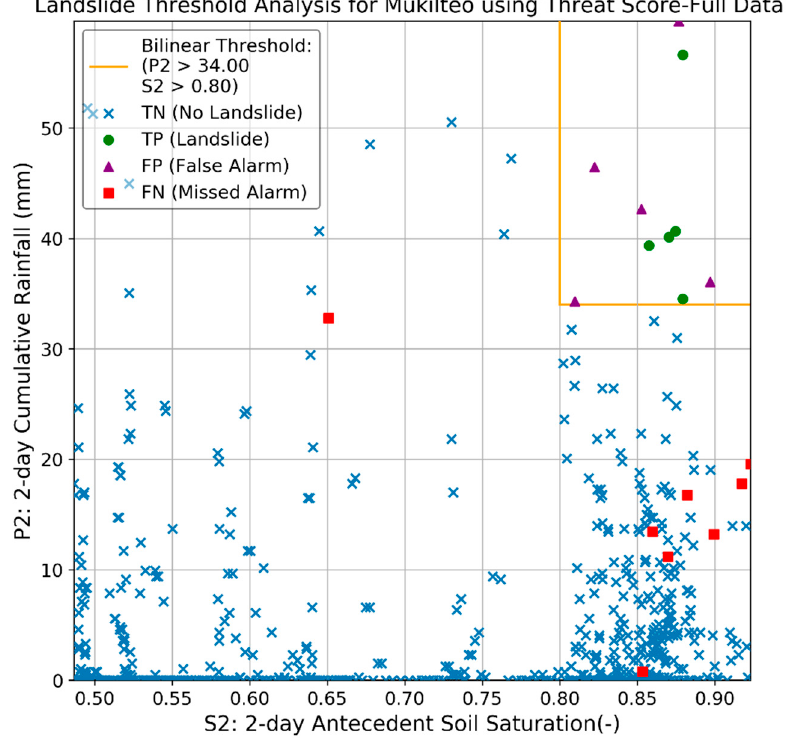
Figure 7. HydroMet output plot showing the optimal threshold for the example in Mukilteo, Wash- ington. The yellow square shows the optimal rainfall and saturation thresholds. The blue Xs are events where there was no landslide and the threshold would have predicted no landslide. The green circles are where a landslide occurred, and the threshold would have correctly predicted a landslide based on the precipitation and saturation values at that time. The purple triangles and red squares are false alarms and missed alarms, respectively, where the threshold incorrectly assumed or missed a landslide event.